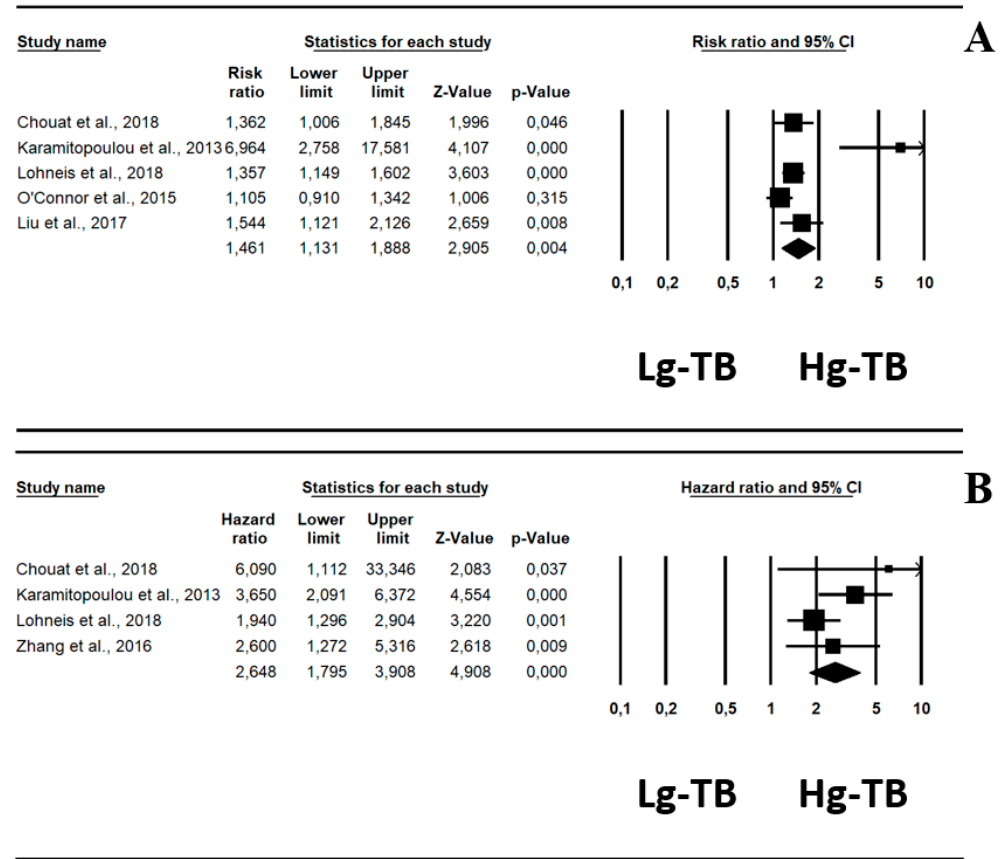
Figure 2. Forrest plot indicating pancreatic ductal adenocarcinoma risk ratio (RR, A ) in pancreatic ductal adenocarcinoma and hazard ratio (HR, B ) for all-cause mortality of patients with high-grade tumor budding (Hg-TB) vs. low-grade tumor budding